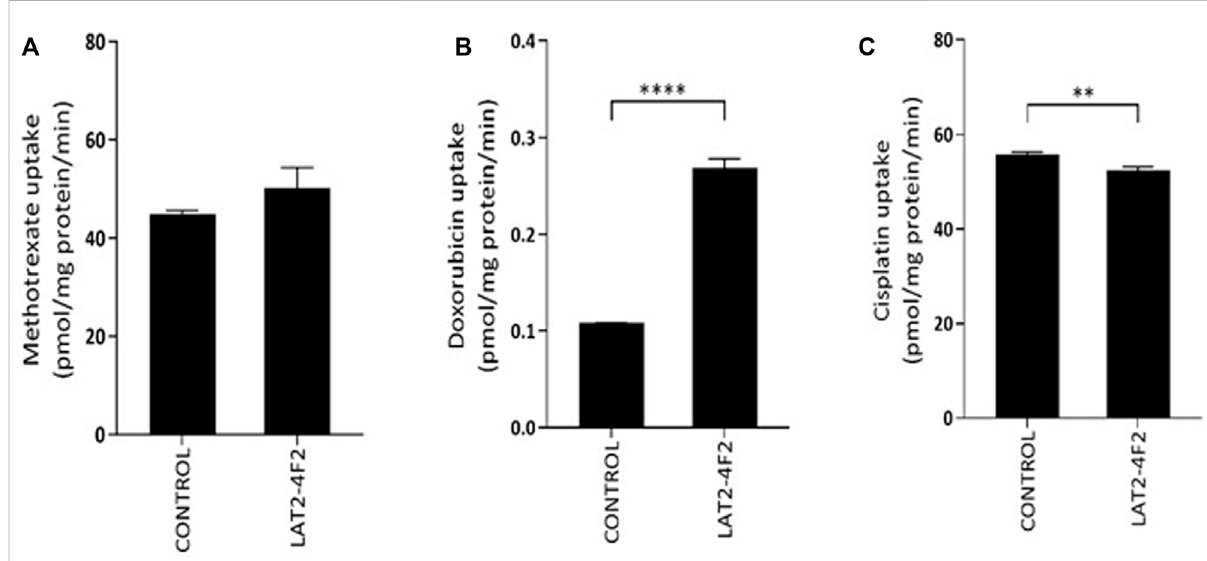
FIGURE 3 Transport assay to assess if methotrexate (A) , doxorubicin (B) or cisplatin (C) are substrates for LAT2-4F2. HEK293 cells were incubated with methotrexate (500 µM), doxorubicin (500 µM) and cisplatin (330 µM) for 30 min at 37 ˚ C. No signi fi cant difference in uptake of methotrexate or cisplatin was found in LAT2-4F2-HEK293 cells ( p = 0.1, p = 0.0028, resp.) compared control cells. Doxorubicin uptake was signi fi cant in LAT2-2F4- HEK293 cells ( p < 0.0001). All data is expressed as mean ± SD (N = 3).